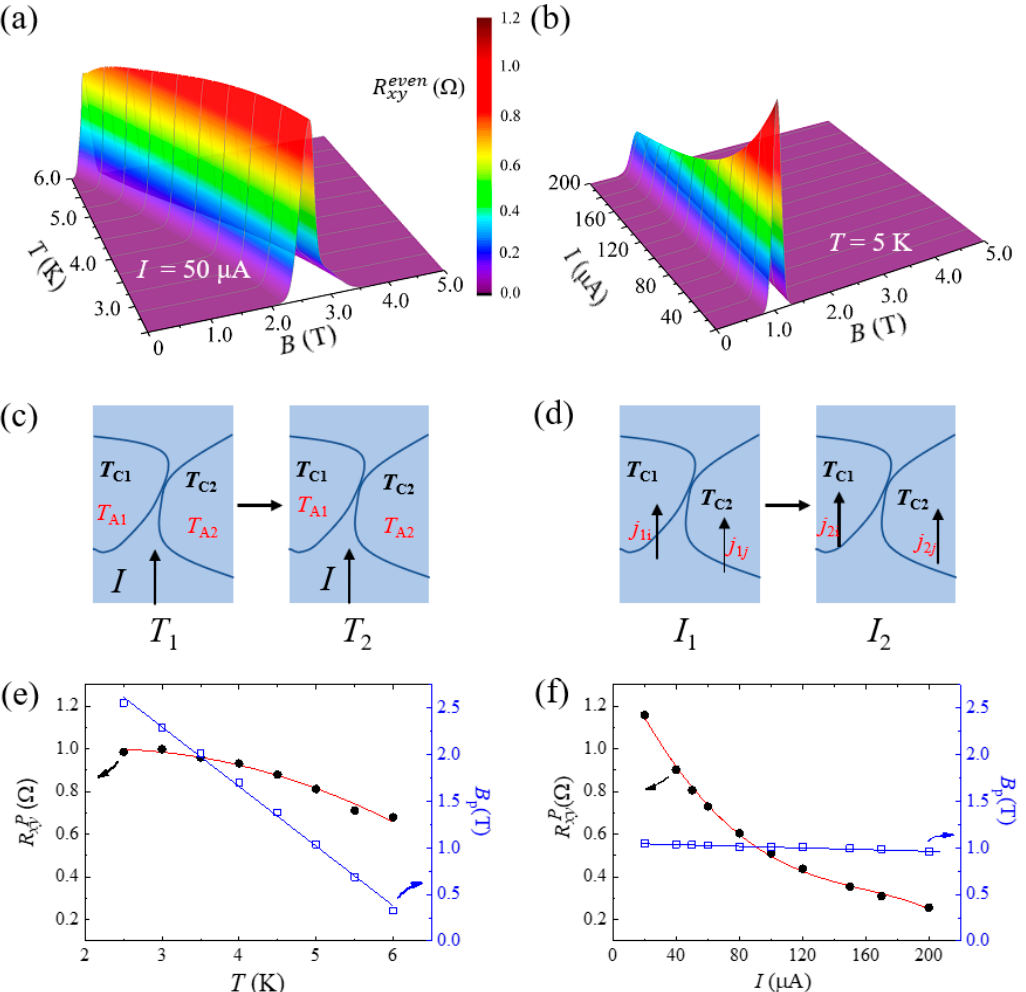
Figure 3. ( a , b ) show the changes in R even xy with temperature and applied current, respectively. A color scale bar is shown in the middle. ( c , d ) are the sketched maps of an inhomogeneous superconductor during current flowing through the Hall bar under different temperature and applied currents. The arrows represent the direction of the applied currents. ( e , f ) Peak values of R even xy (black dots) and the corresponding fields (blue squares) as a function of temperatures and current densities, respectively. The red lines are the theoretical fitting.